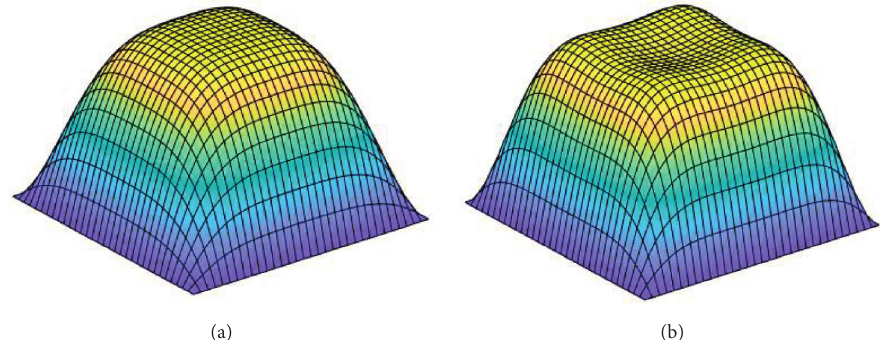
Figure 6: The deflection shapes of the plate in two case (a) K